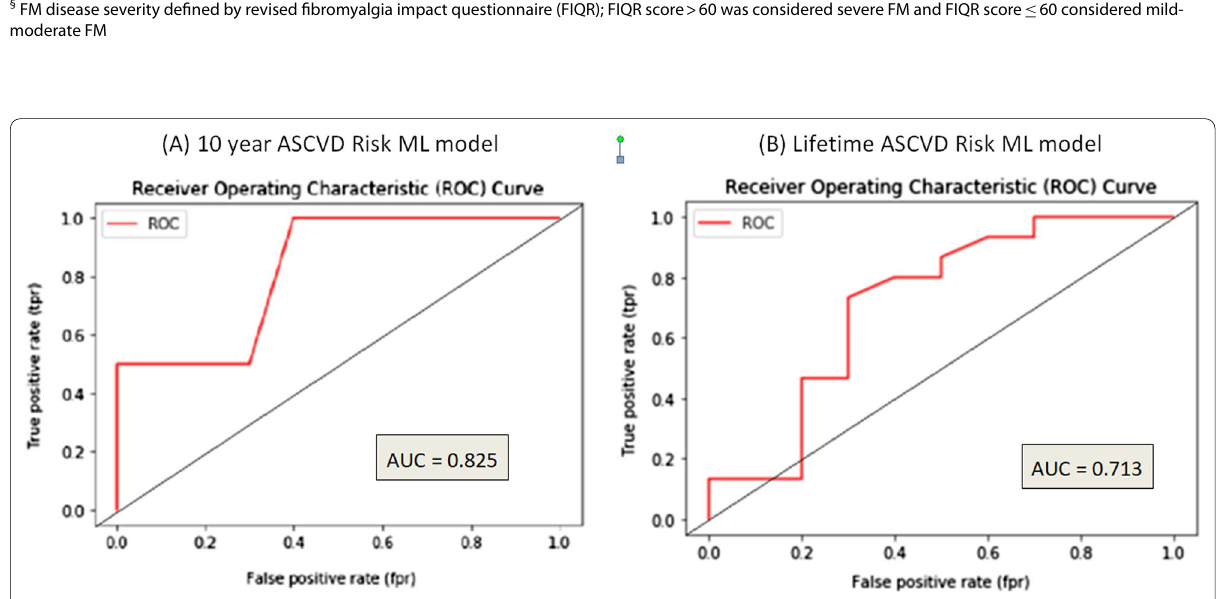
Fig. 2 R.O.C curve of the best machine learning models for ASCVD risk